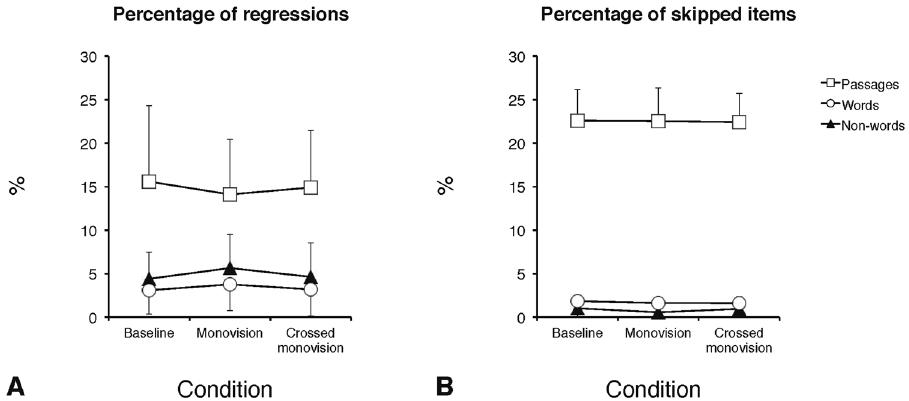
Figure 3. Group means for EM parameters: percentage of regressions ( A ) and of skipped items ( B ). Data are separately presented for text passages, words, and non-words and as a function of the three experimental CL conditions (baseline, monovision, and crossed monovision). Error bars represent standard